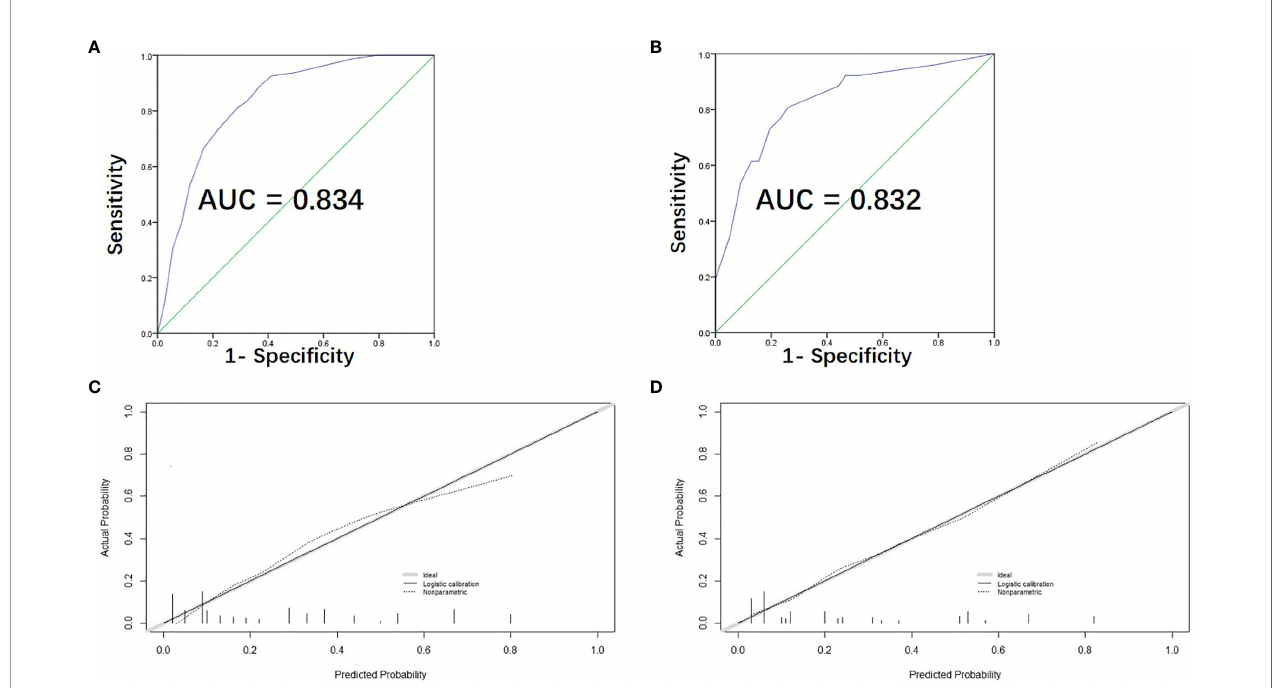
FIGURE 3 | Assessment, and validation of the predictive model. (A) The ROC curve and AUC of the risk-scoring model; ROC receiver operating characteristics. (B) The ROC curve and AUC for external validation group. (C) The calibration curve of the risk-scoring model for predicting LLNM risk. Actual probability is plotted on the y-axis, and nomogram predicted probability on the x-axis. (D) The calibration curve for external validation group.